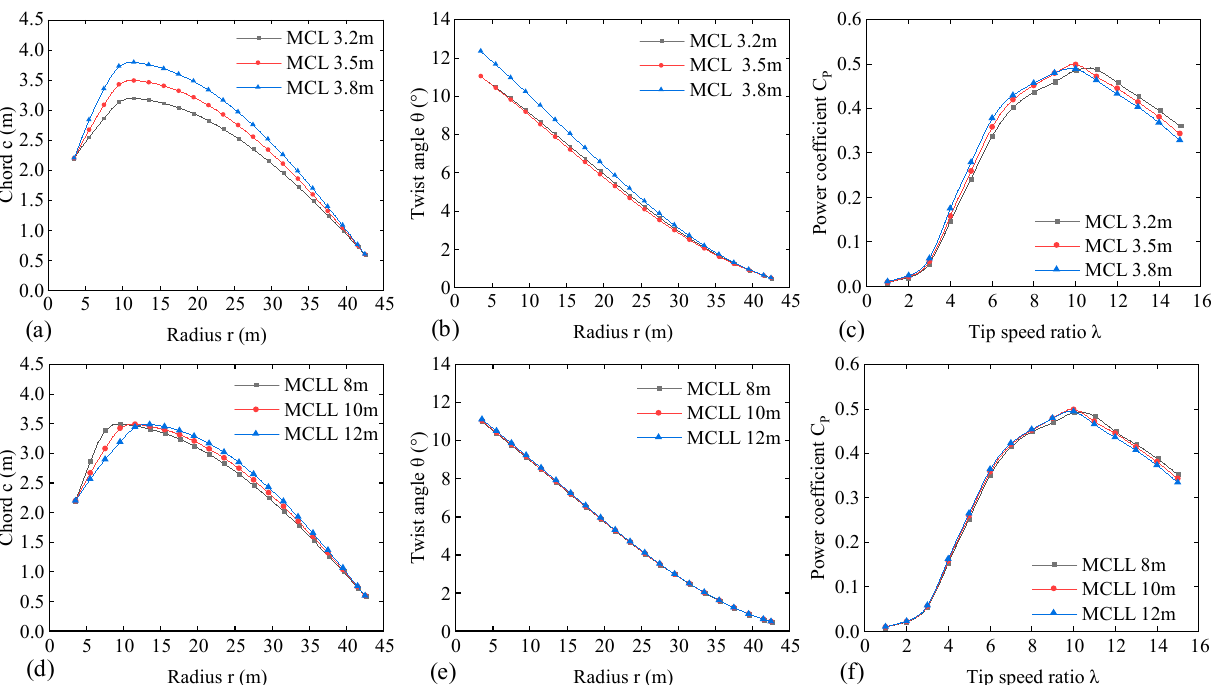
Figure 8. Effect of the value and location of the maximum chord length. (Note: MCL is the abbreviation for maximum chord length and MCLL is the abbreviation for maximum chord length location.). ( a ) chord length of MCL; ( b ) Twist angle of MCL; ( c ) Power coefficient of MCL; ( d ) chord length of MCLL; ( e ) Twist angle of MCLL; ( f ) Power coefficient of MCLL.